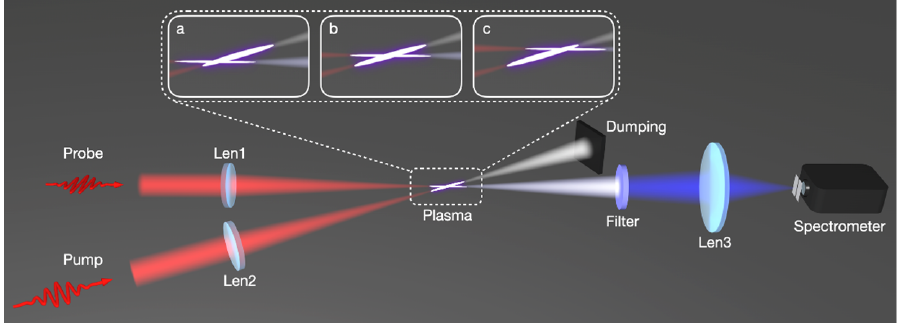
Figure 1. Schematic diagram of experimental setup. Illustration a, b, c shows the pump pulse at different locations along the plasma string was detected by the probe pulse.